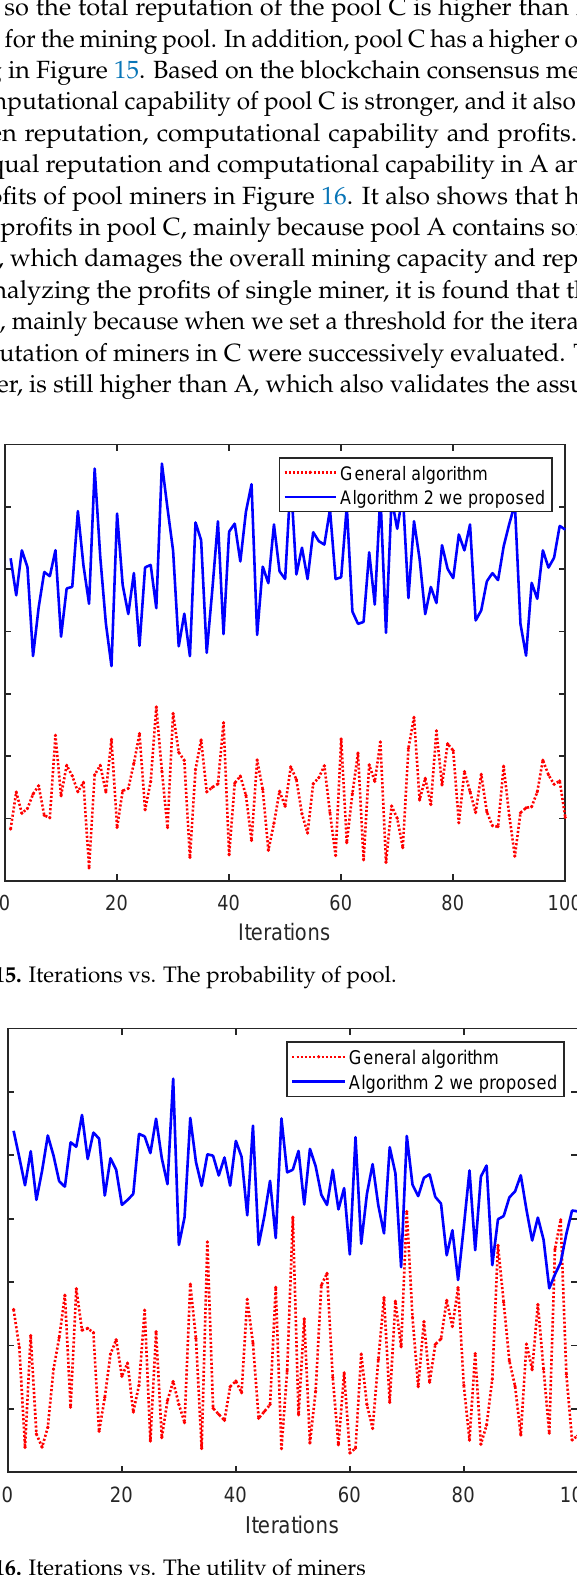
Figure 16. Iterations vs. The utility of